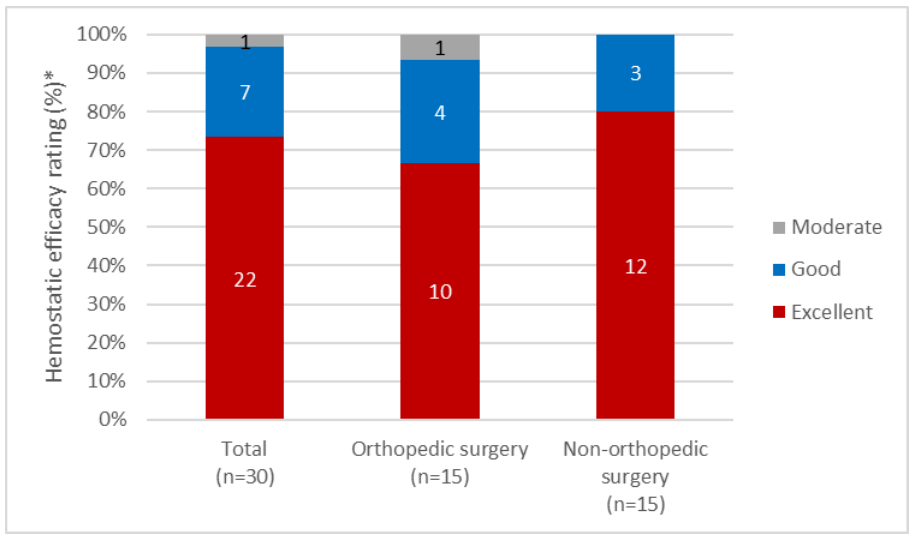
Figure 2. Hemostatic efficacy rating of rIX-FP in surgery. * Hemostatic efficacy ratings provided by the investigator/surgeon Figure adapted from Negrier, C.; et al. Haemophilia 2016 , 22 , e259 – e266 and Pan-Petesch, B.; et al. Thromb. Res. 2020 , 193 , 139 – 141.